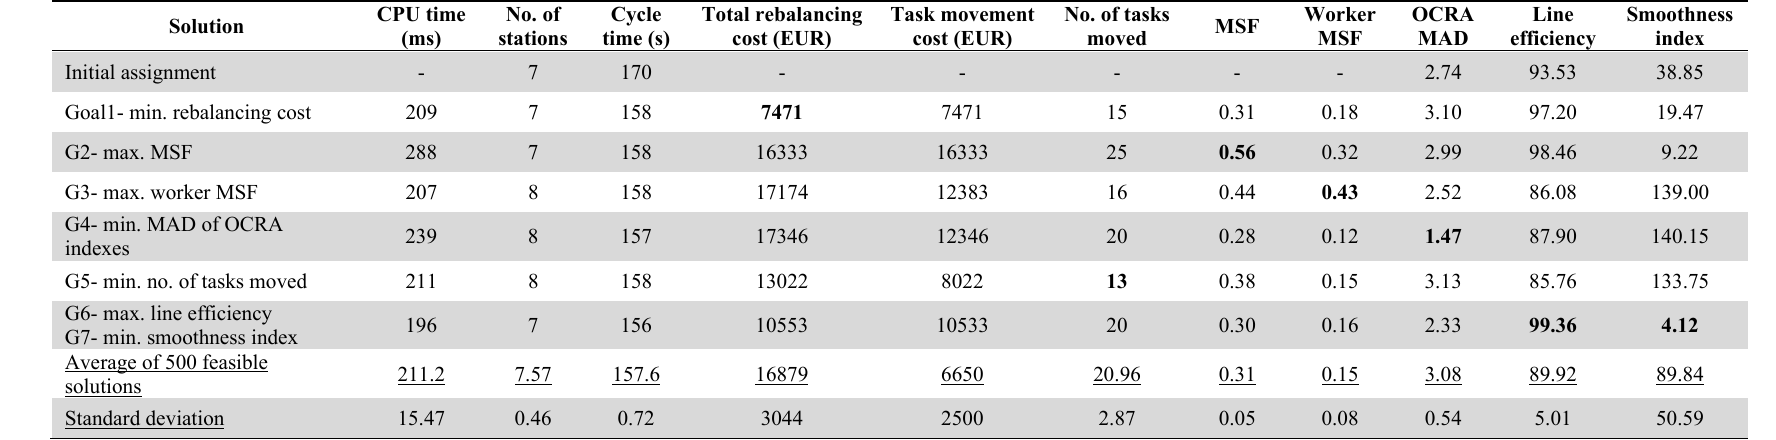
Computational results of the industrial case